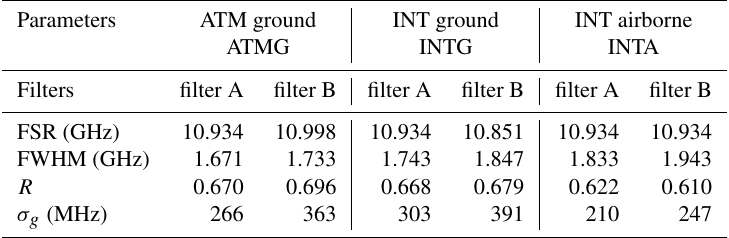
Table 3. Specific parameters of FPIs during different ground and airborne campaigns illustrated in Fig. 5.